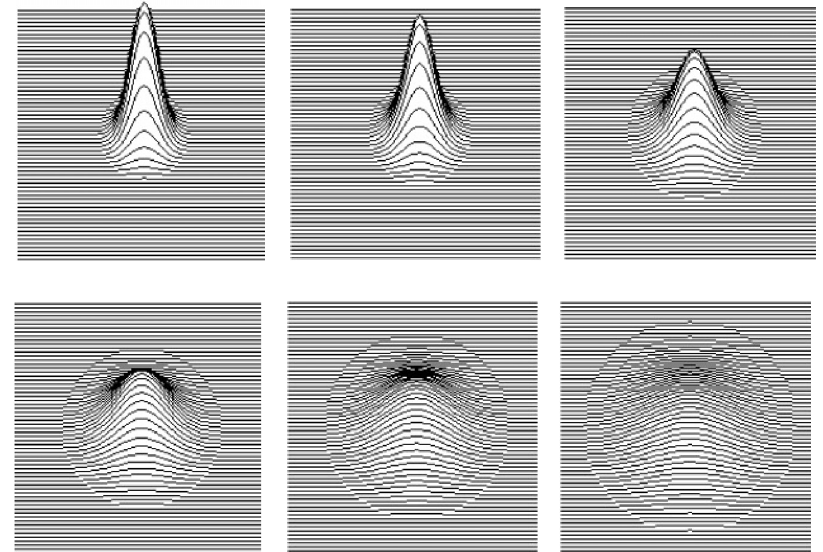
Figure 6.1 . Evolution of a Gaussian pulse on distance π with initial amplitude constant A 0 = 0 . 8, governed by the scalar NSE (6.1). This corresponds to the nonlinear parameter γ < 1 and the dominating